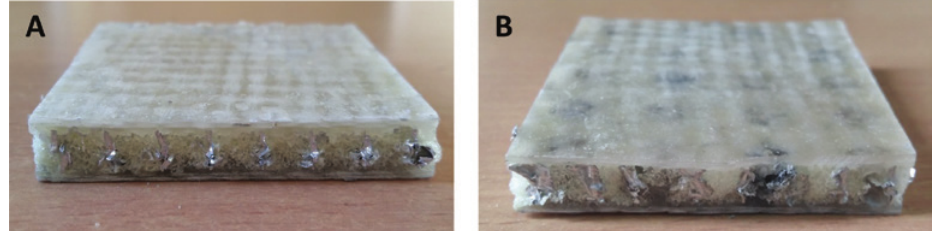
Figure 9: Specimens after flatwise compression test, (A) FHS panel and (B) PFHS panels.